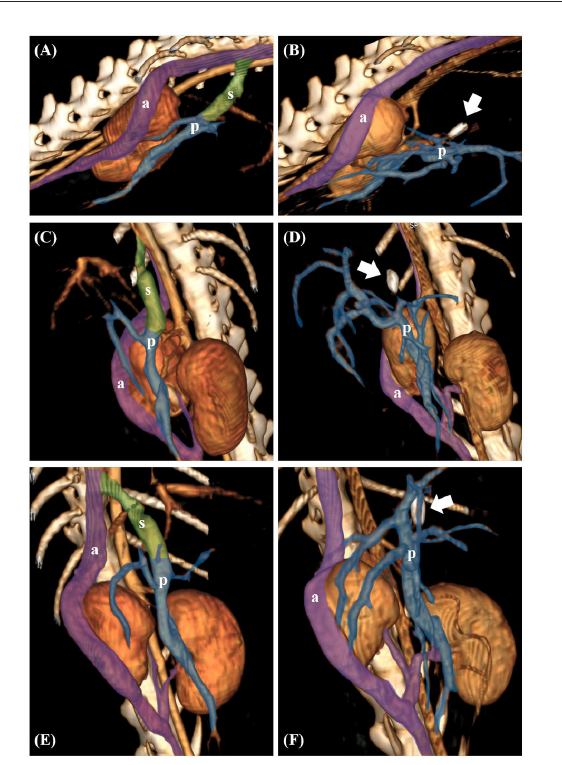
FIGURE4 Preoperative volume-rendered three-dimensional (3D) images in case 1 (A,C,E) . Postoperative volume-rendered 3D images in case 1 revealed complete occlusion of the shunt (white arrow indicates surgical clip) (B,D,F) . The transparent green area represents the shunt (s). The transparent purple area represents the right azygos vein (a) and the transparent blue area represents the portal vein (p), respectively.